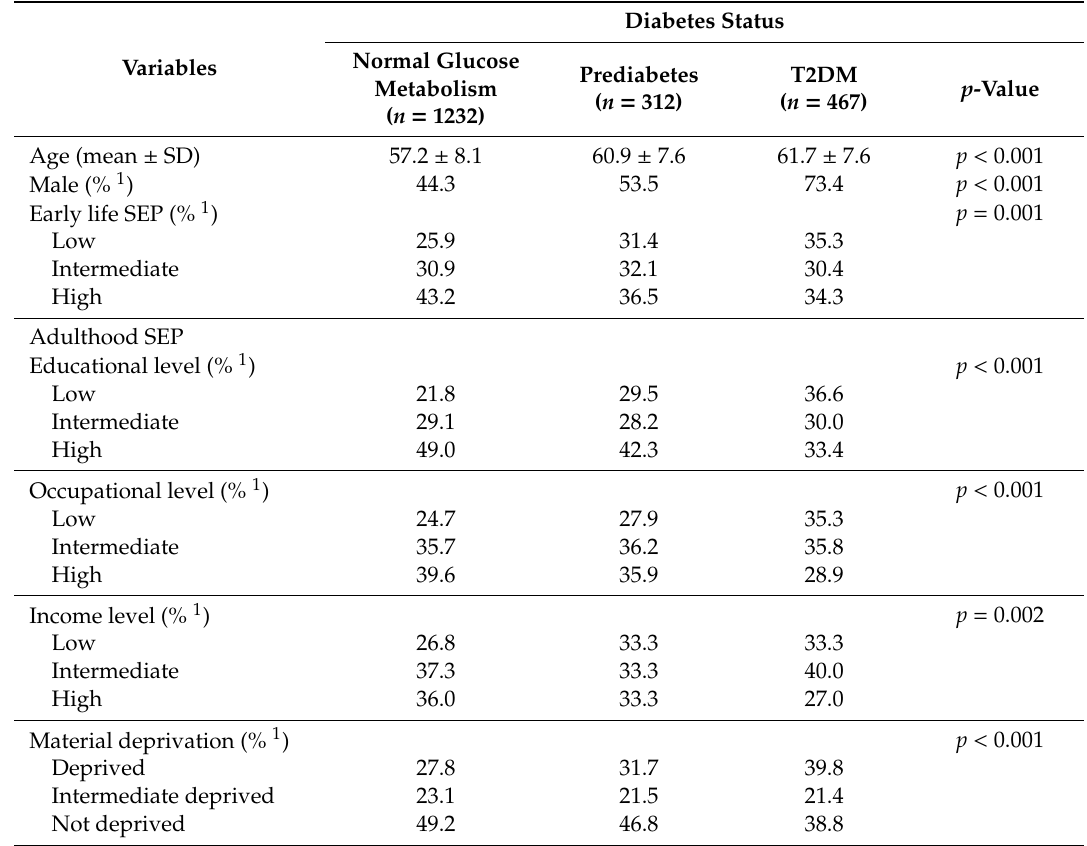
Table 1. Demographics, early life socioeconomic position (SEP), educational level, occupational level, income level and material deprivation by diabetes